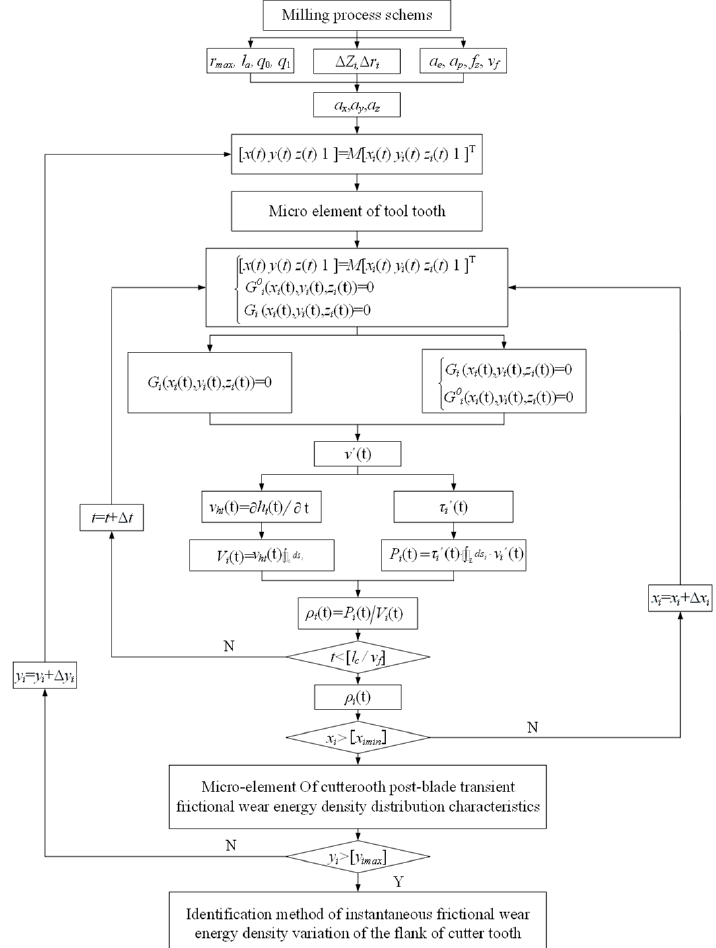
Figure 8. Identi fi cation of friction and wear energy density variation on the tool fl ank. Figure 8. Identification of friction and wear energy density variation on the tool flank.